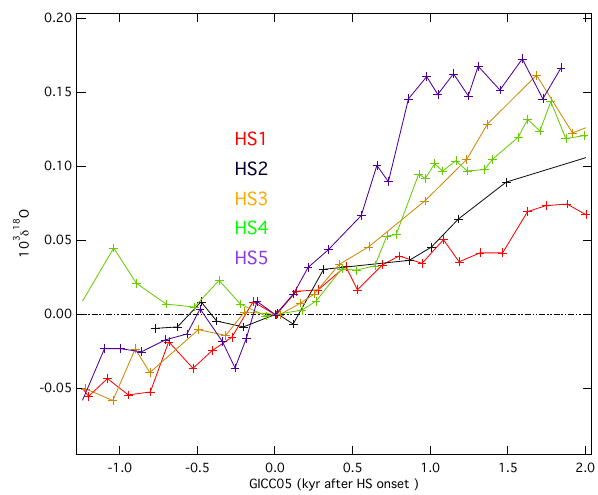
Figure 2. Evolution of Siple Dome atmospheric oxygen δ 18 O (Sev- eringhaus et al., 2009) during Heinrich stadials on the GICC05